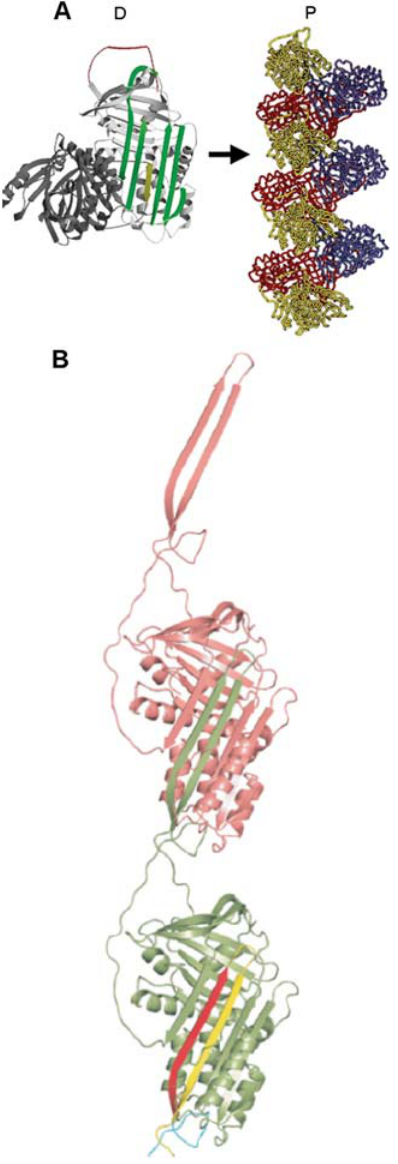
Figure 6 The two models proposed for the assembly of patholog- ical A-sheet serpin polymers. (A) The model proposed by Lomas et al. (103) is based on the swapping of the RCL region alone (D indicates dimer, P denotes polymer). Adapted, with permission, from Birkha¨user Basel, Cell Mol Life Sci (2006; 63: 709–22), (cid:2) (2006). (B) The model proposed by Yamasaki et al. (104) is based on the swapping of a more extended serpin region, comprising the RCL and the neighboring strand s5A. Adapted, with permission, from Macmillan Publishers Ltd., Nature (2008; 455: 1255–8), (cid:2)